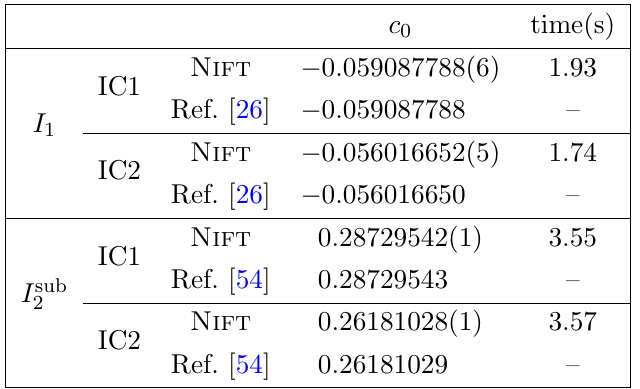
{ . The two initial points are: IC1( s = 1 : 33, 2 (cid:0) 1 : 63 ; t = 0 : 632). c 0 is the leading term of the (cid:15) expansion of these (cid:0) (cid:0)